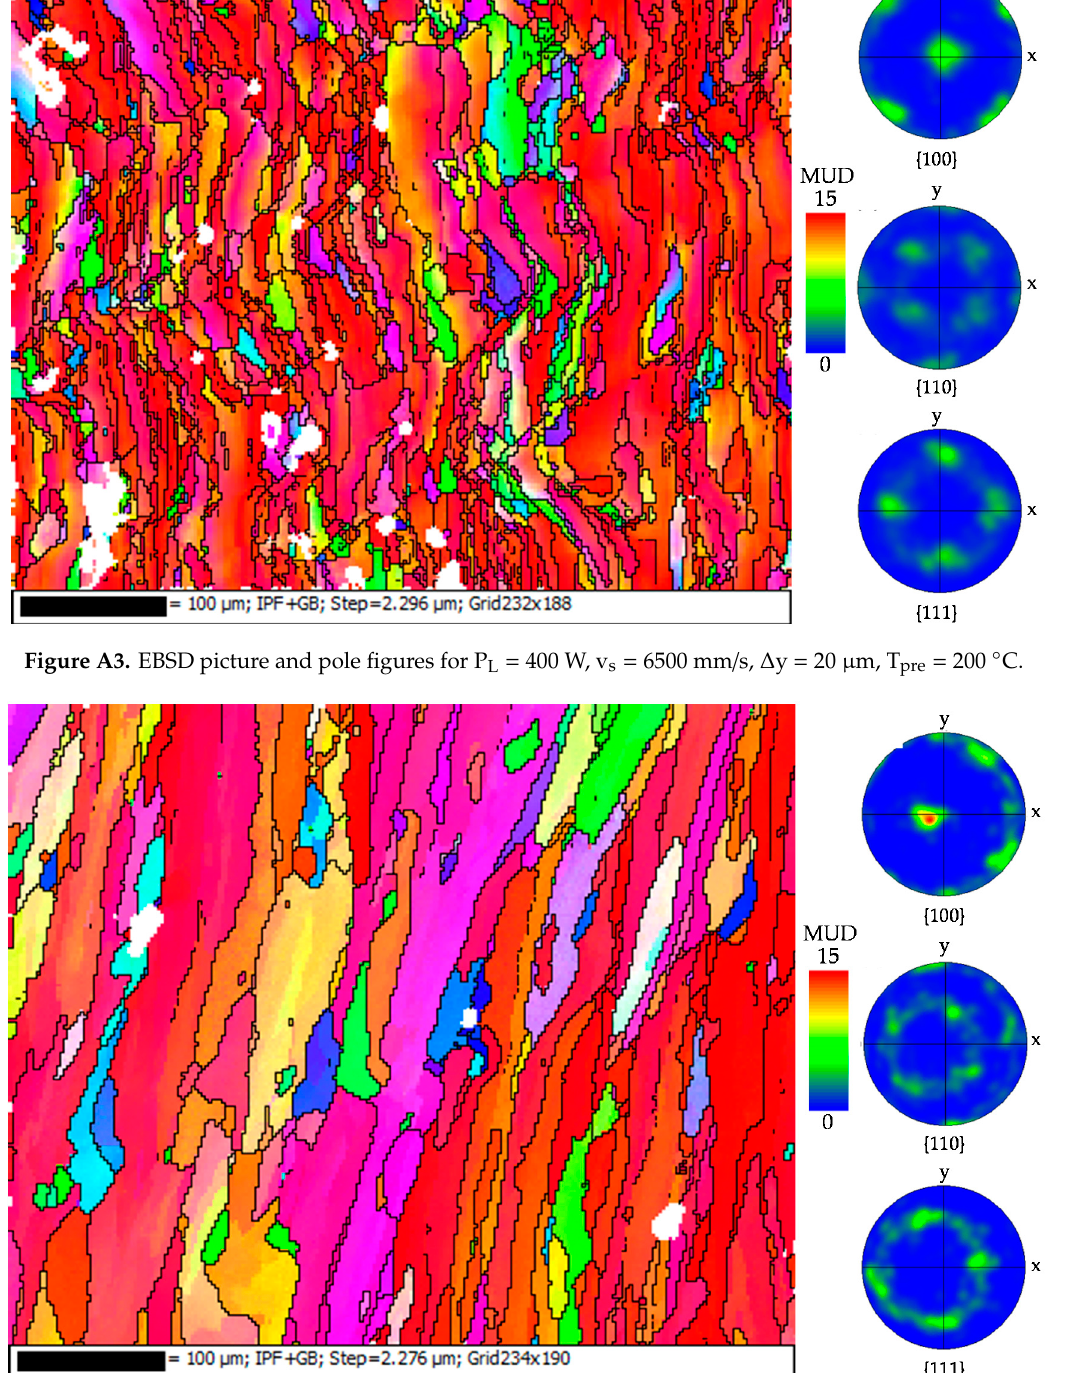
Figure A4. EBSD picture and pole figures for P L = 200 W, v s = 83 mm/s, Δ y = 70 µm, T pre = 3500 °C.